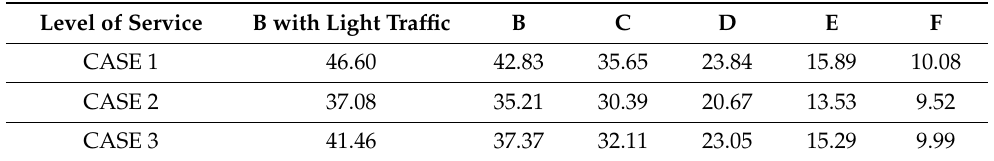
Table 4. Average travel speed